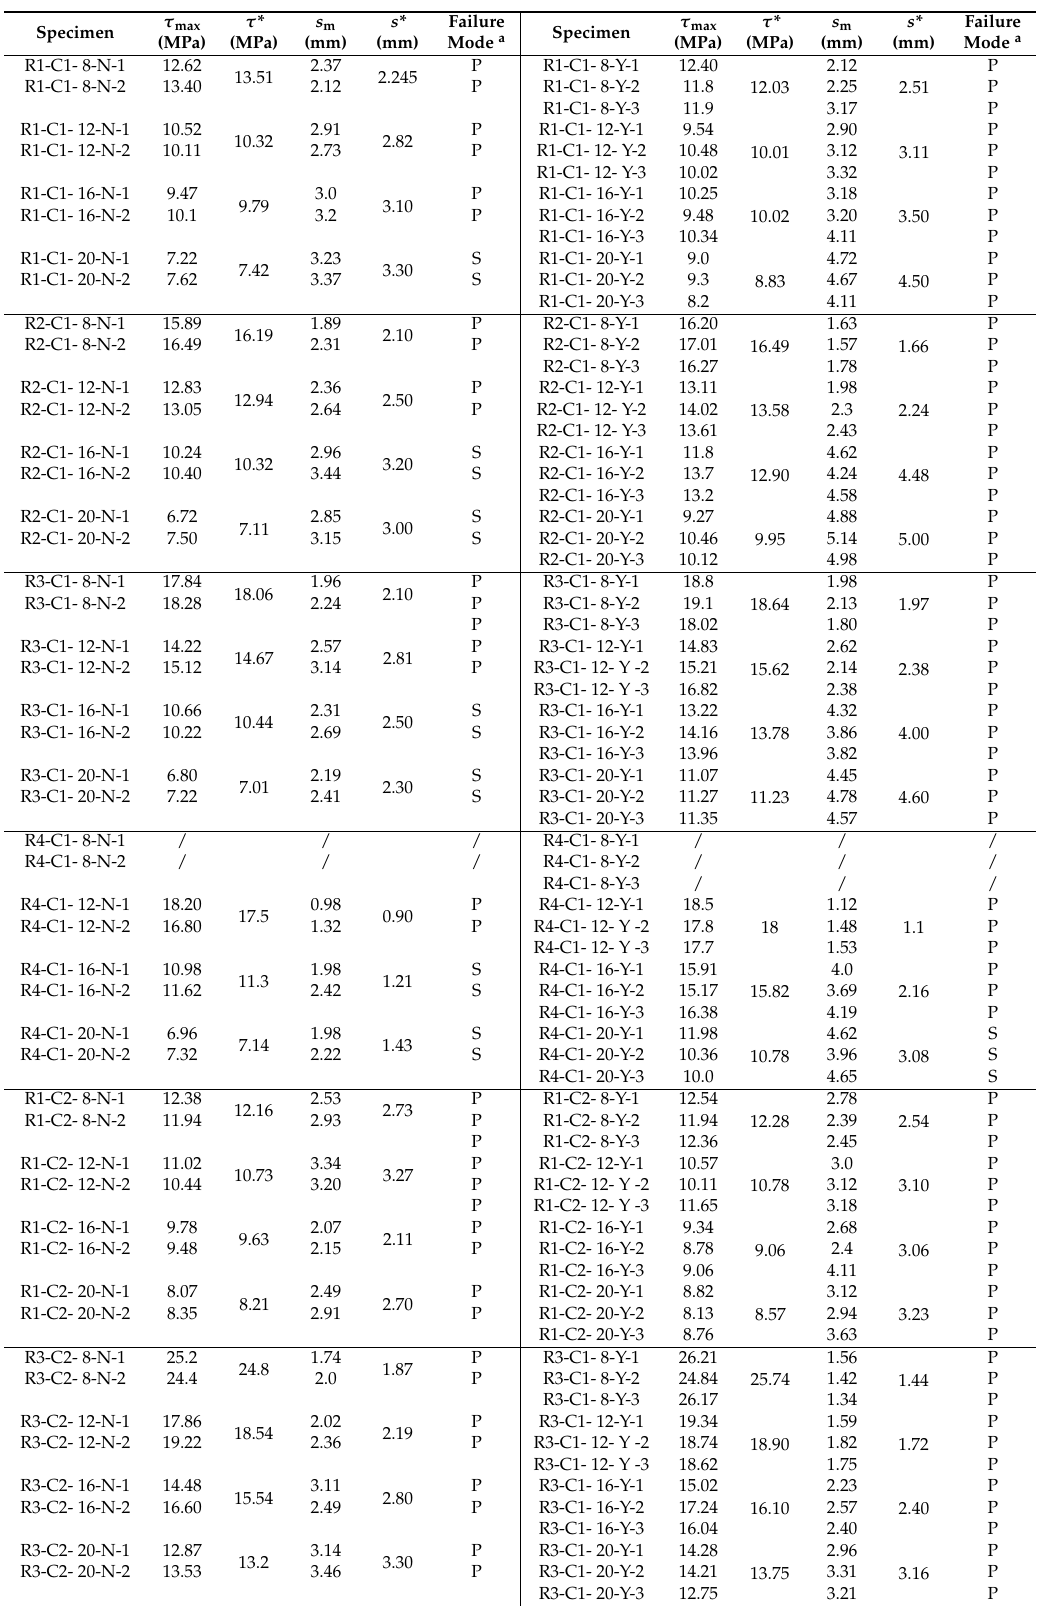
Table 3. Experimental results for